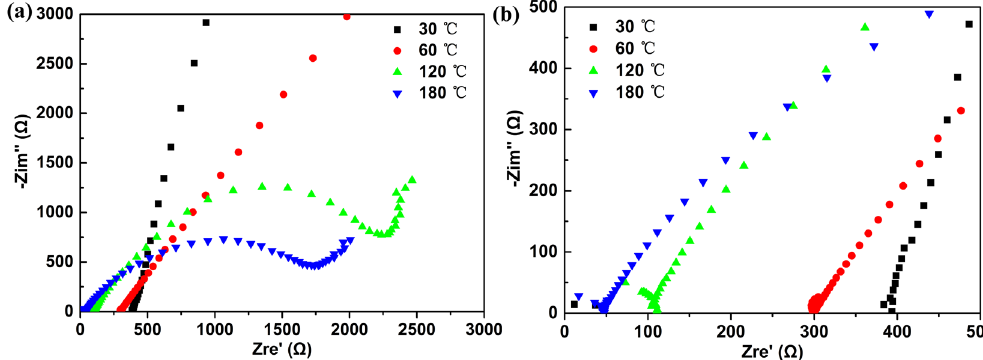
Figure 6. ( a ) Representative Nyquist plots of 40 (0.2Ga 2 S 3 -0.8Sb 2 S 3 ) − 60AgI glass at 30 °C, 60 °C, 120 °C, and 180 °C. ( b ) The magnified image of Nyquist plots of 40(0.2Ga 2 S 3 -0.8Sb 2 S 3 ) − 60AgI glass at high frequency